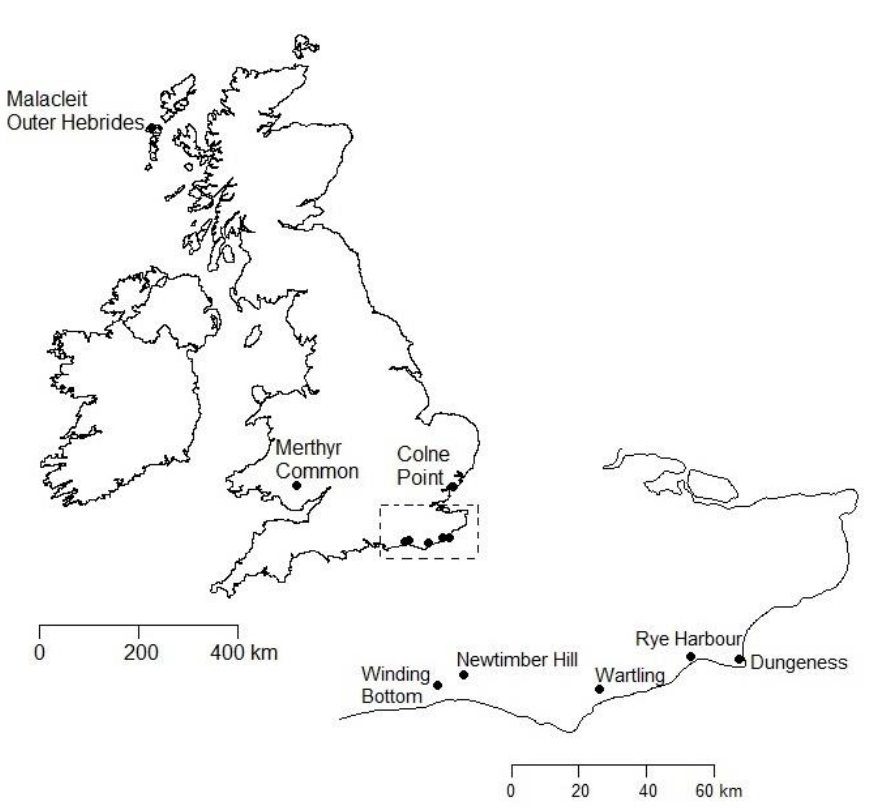
Figure 1. United Kingdom locations where Anoscopus were sampled (site details given in Table 1) with enlarged inset for SE England. Scale bars indicate distances in kilometers.